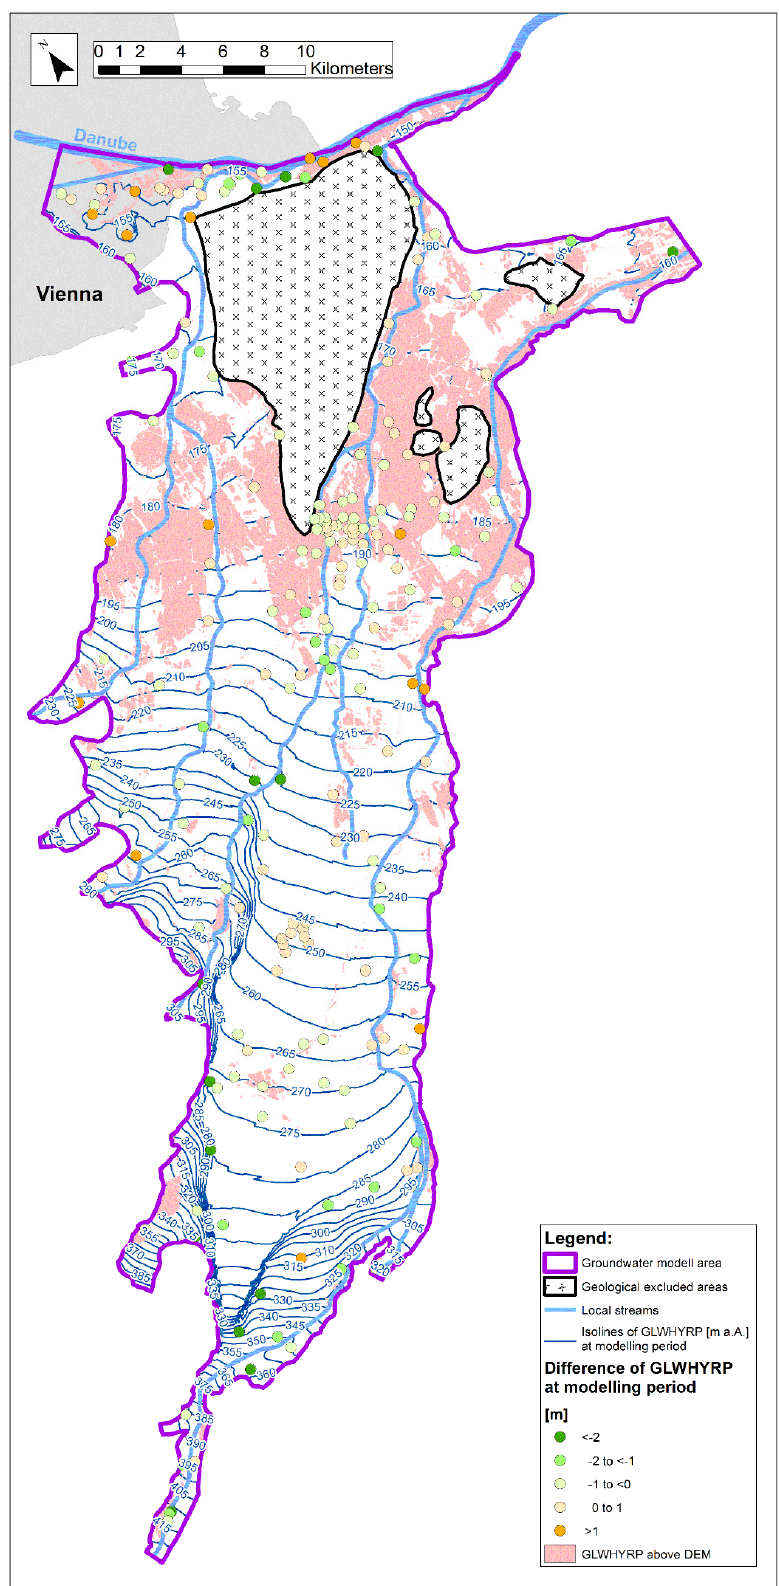
Figure 3. Distribution of GLsWHYRP based on modelled groundwater levels and discrepancies between model-based and observation-based GLsWHYRP at observation wells.